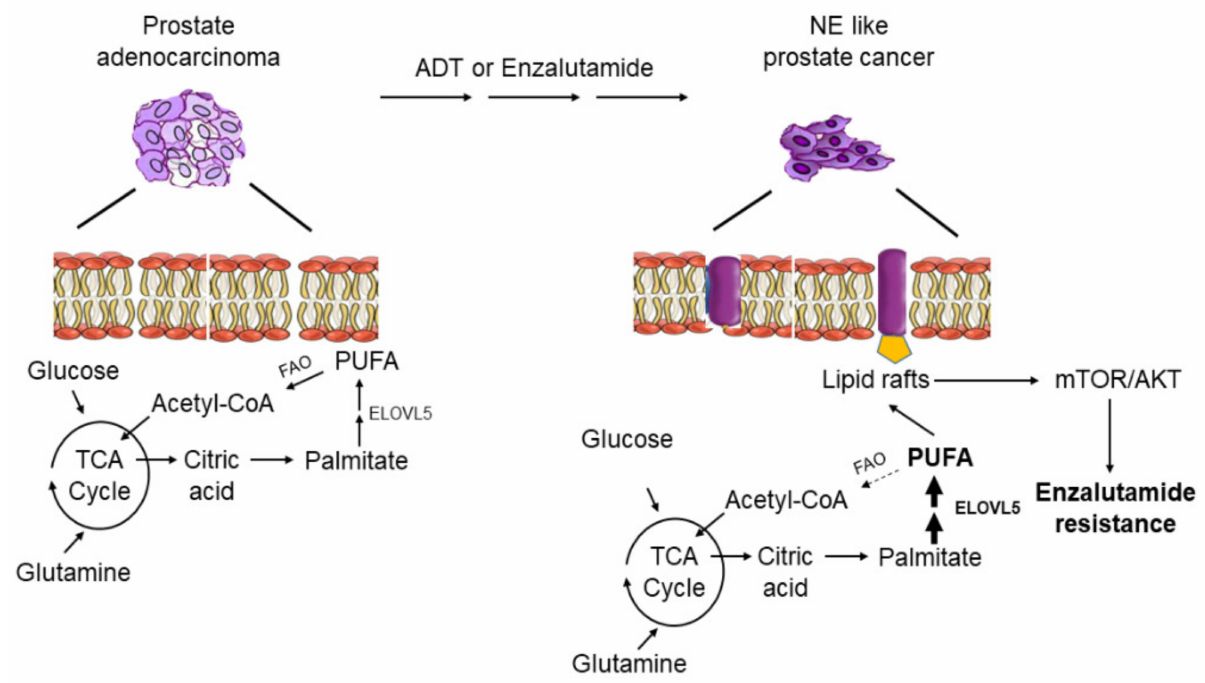
Figure 5. A working model of ELOVL5 induced enzalutamide resistance in NE-like PCa